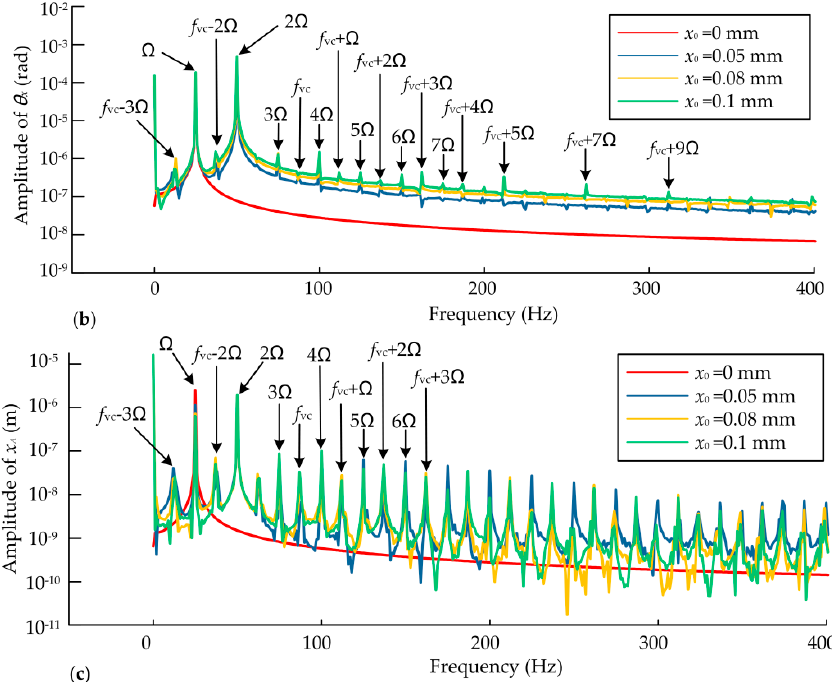
Figure 8. The spectra of dynamic responses for different static displacement eccentricities. ( a ) The spectra of x ; ( b ) The spectra of θ x ; ( c ) The spectra of x A .